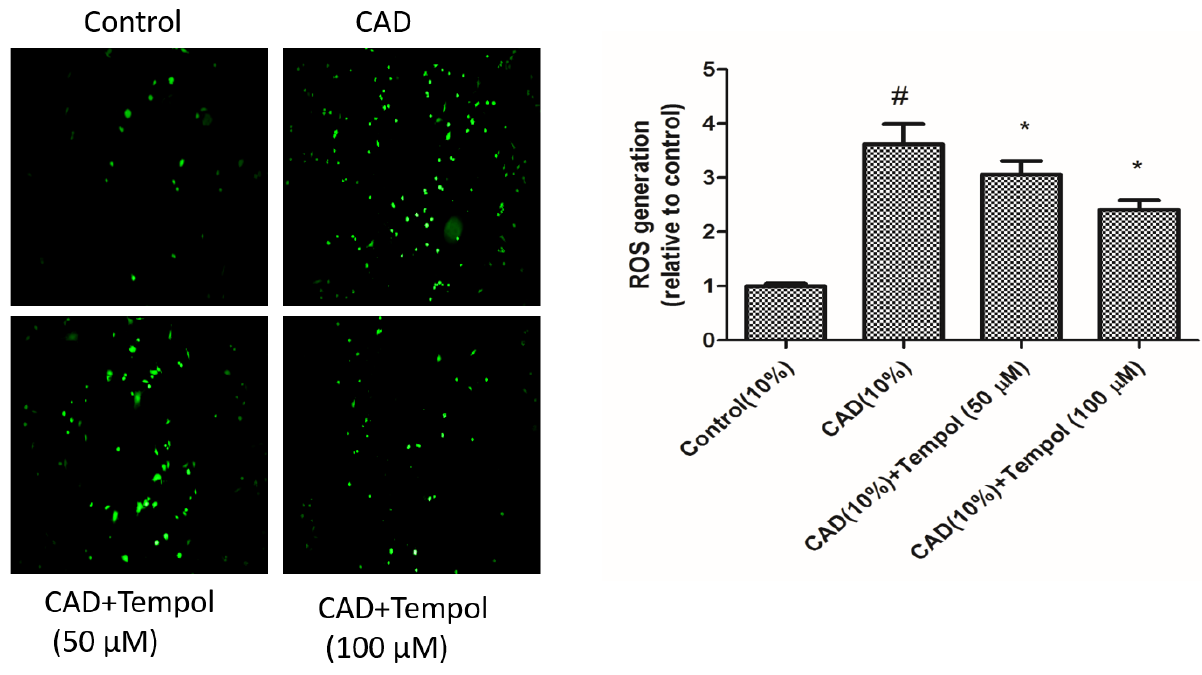
Figure 4: Effects of CAD serum on ROS levels of HUVECs. HUVECs were treated with 10% CAD serum+ tempol (50 or 100 µM) for 24 h, and the ROS level was assessed. *p<0.05, **p<0.01 vs. Control group.